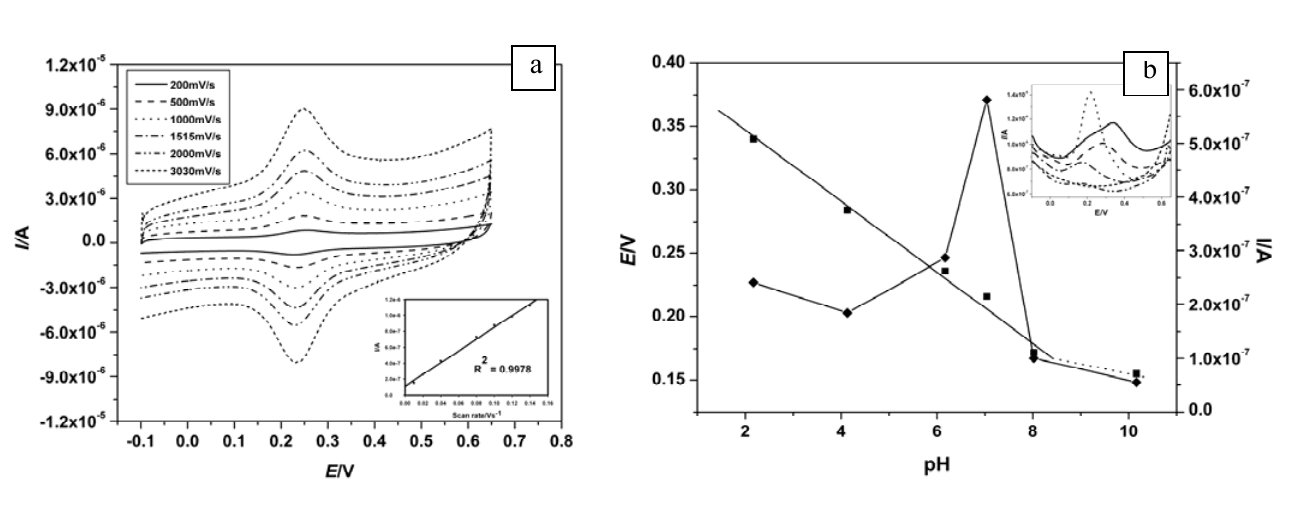
Figure 4. (a) CV of the GCE/PPI-AuNP in PBS as a function of scan rate (inset is the scan ). (b) Plot of E and I vs pH and SWV (inset) response of platform in rate dependence of I pa pa pa 0.1 M PBS ant different